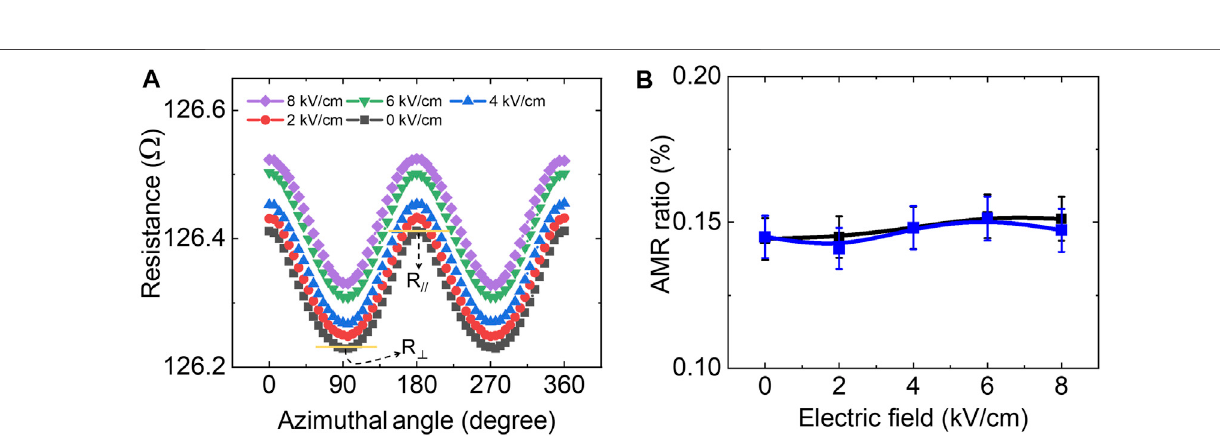
FIGURE 4 | (A) Circle transfer curves under different E- fi eld bias. The saturated magnetic fi eld ~35 Oe was chosen to perform this measurement. R ⊥ and R (cid:3) is minimalandmaximalmagnetoresistancevalueintheCTCs,respectively. (B) AMRratioisasafunctionoftheappliedelectric fi elds.Theblackandbluesymbolsrepresent the AMR ratio derived by TC and CTC measurements,